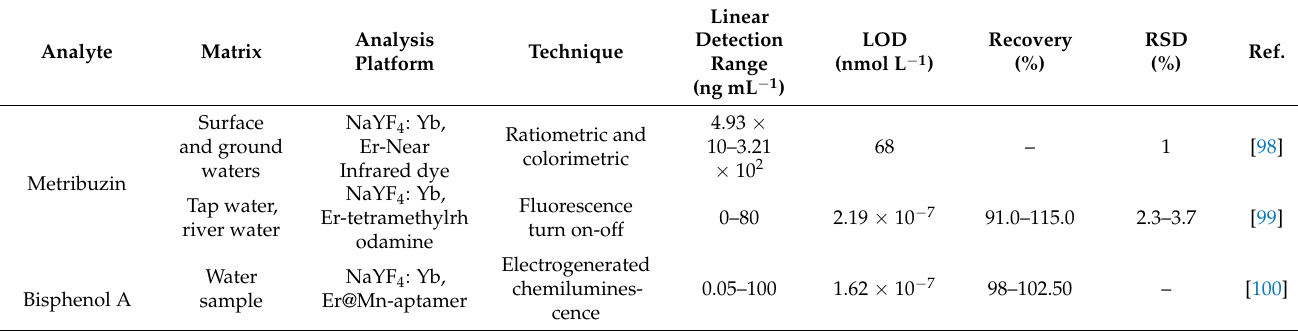
Table 3. A summary of achievements in analysis of pollutants in environmental science through UCNPs